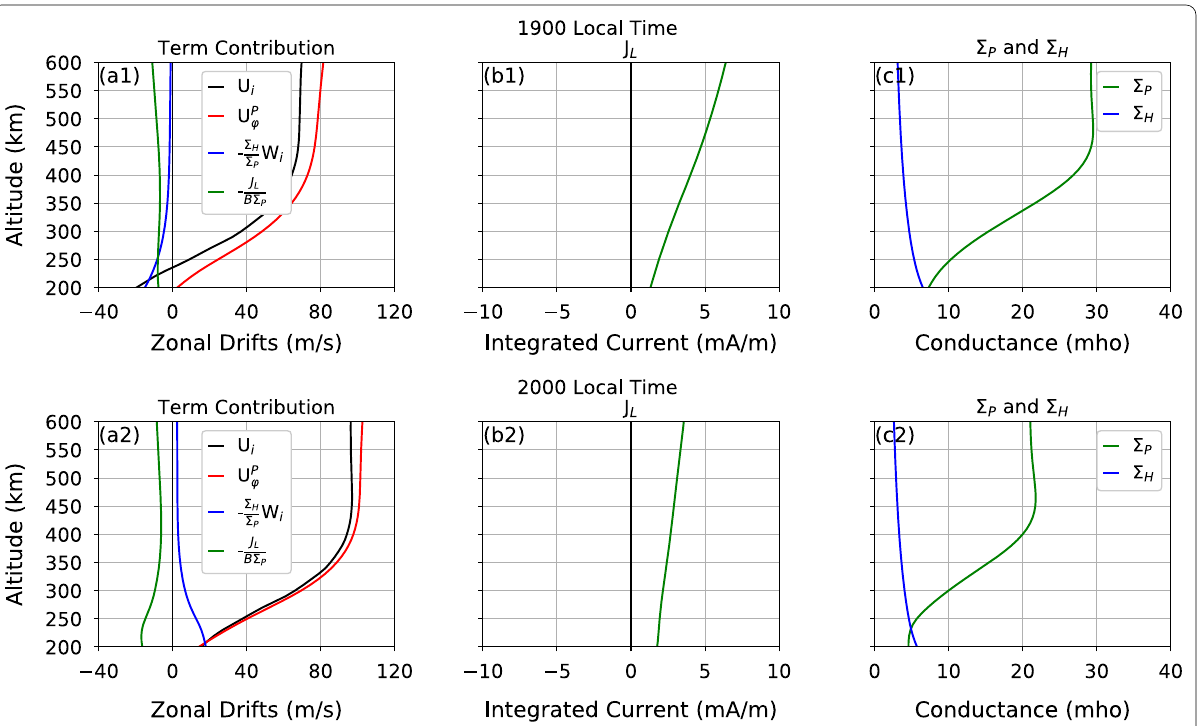
Fig. 7 On the contribution of J L to the morphology of the zonal plasma drifts at 1900 LT (top) and 2000 LT (bottom). Panels a1 and a2 show the apex height profiles of the zonal plasma drifts modeled by DINAMO for equinox HSF conditions. Panels b1 and b2 show apex height profiles J L . Finally, panels c1 and c2 shows apex height profiles of Pedersen and Hall